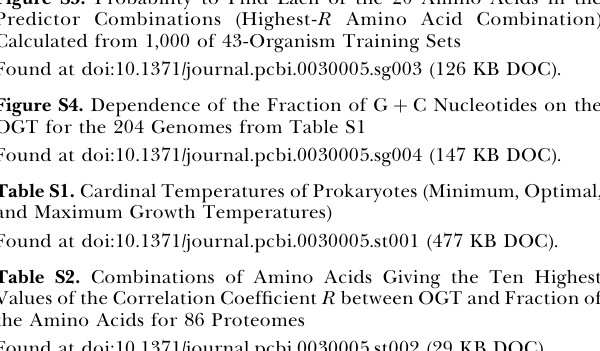
Table S3. Organisms Used for Prediction of Transmembrane Beta Barrel Proteins and Their OGT Found at doi:10.1371/journal.pcbi.0030005.st003 (44 KB DOC). Table S4. Combinations of Nucleotides and Correlation Coefficients between OGT and Fraction of the Corresponding Nucleotides in the Coding DNA of 83 Organisms Table S5. Correlation Coefficients R between OGT and Amino Acids and Pairs of Amino